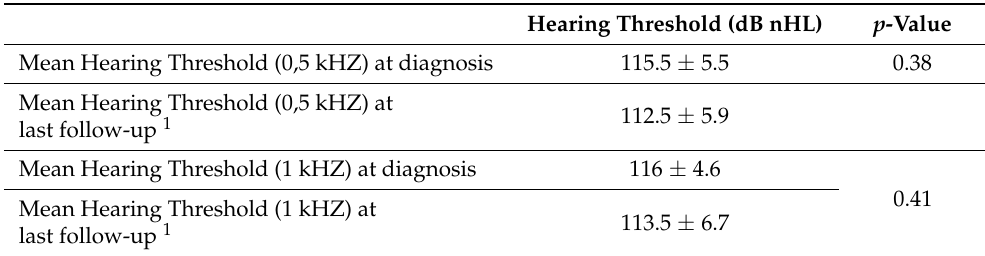
Table 3. Mean hearing threshold at diagnosis and at the last follow-up on the non-implanted side in the 8 subjects with residual hearing below 2